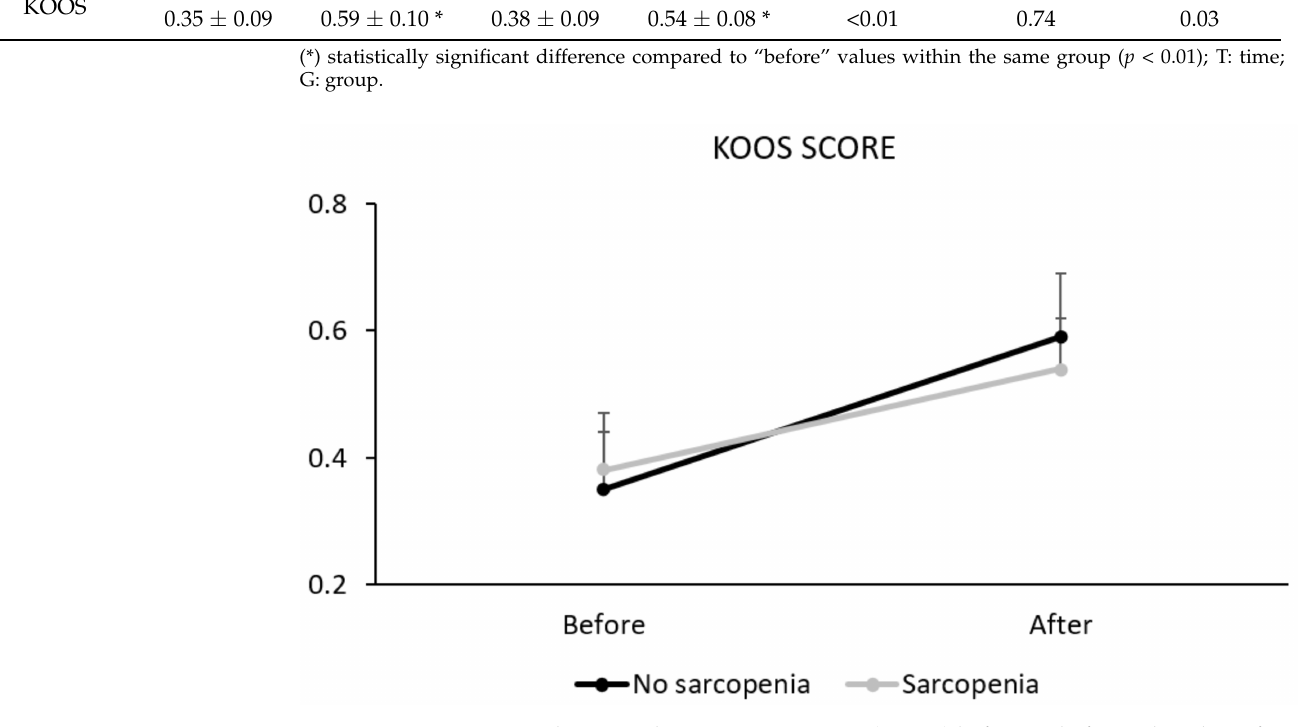
Figure 2. Knee Injury and Osteoarthritis Outcome Score (KOOS) before and after arthroplasty for sarcopenic and non-sarcopenic